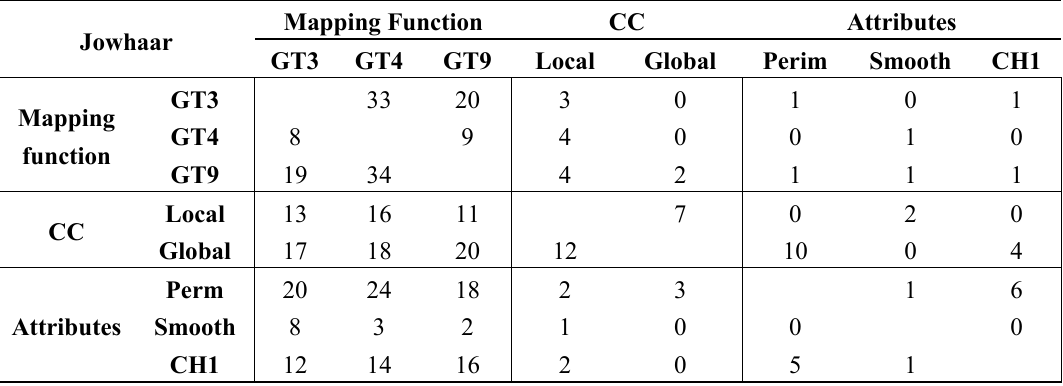
Table 5. Interdependency test of the method constituents for the Jowhaar problem. Jowhaar